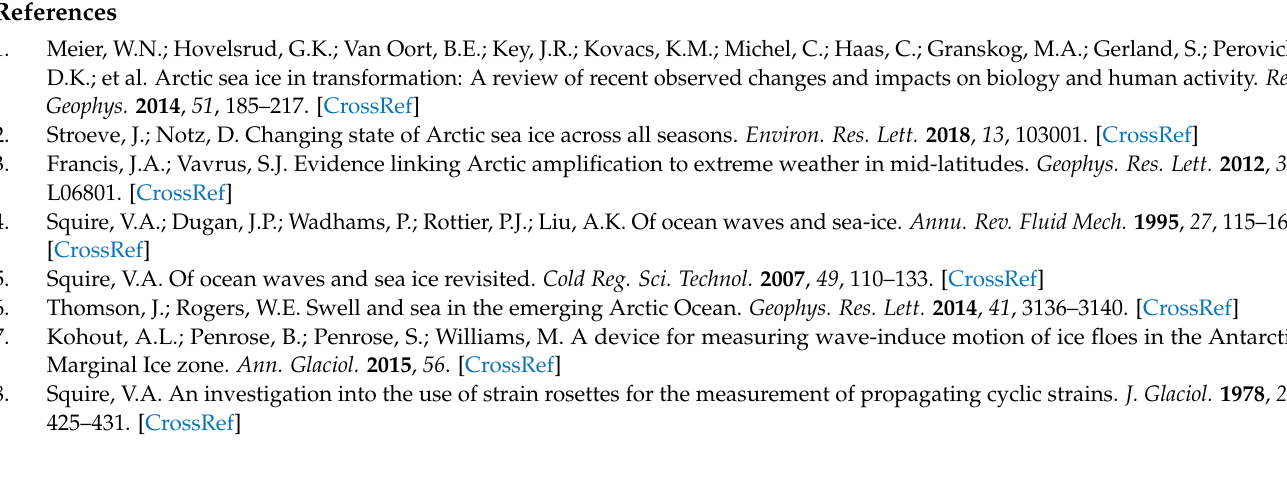
Figure A1. Dependencies of the term ρ a α k 2 / ( g ρ w ) from the wave number k calculated with h ∗ = 1 m and three different values of H ( a ) and H = 1000 m and three different values of h ∗ ( b ).